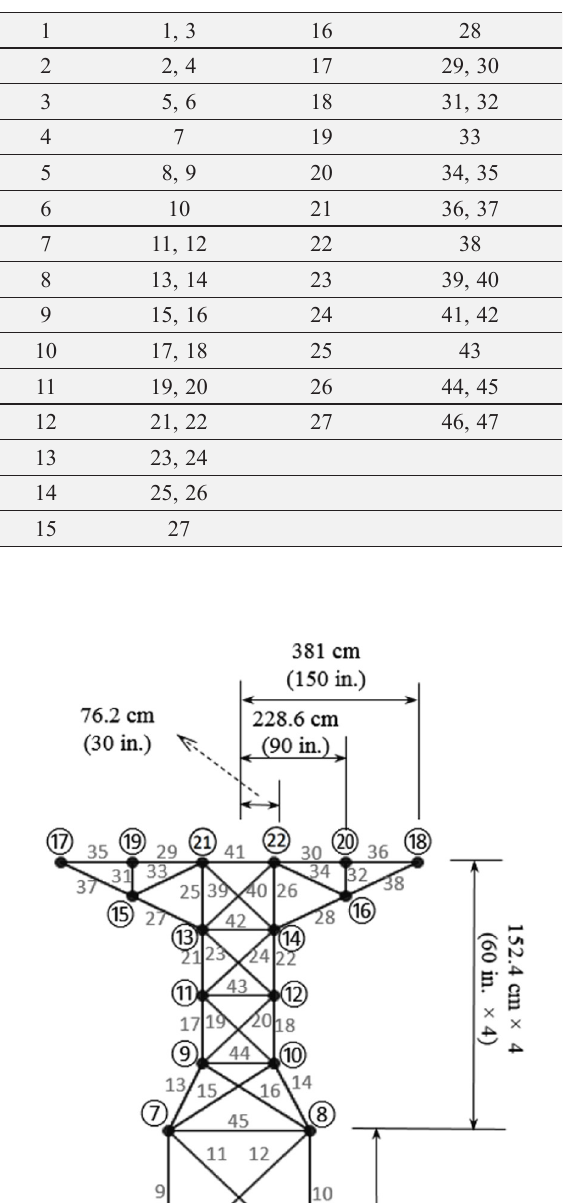
Table 12. Member grouping for the planar 47-bar truss problem Group